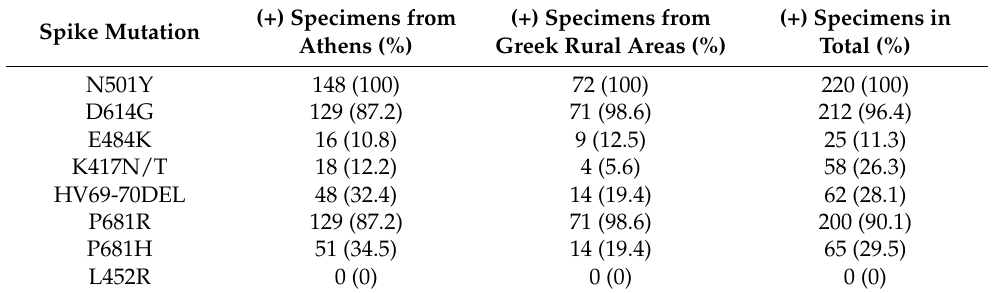
Table 1. Spike mutations investigated in our study and their proportion in the collected specimens. (+) Specimens from (+) Specimens from (+) Specimens in Spike Mutation Athens (%) Greek Rural Areas (%) Total (%) N501Y 148 (100) 72 (100) 220 (100) D614G 129 (87.2) 71 (98.6) 212 (96.4) E484K 16 (10.8) 9 (12.5) 25 (11.3) K417N/T 18 (12.2) 4 (5.6) 58 (26.3) HV69-70DEL 48 (32.4) 14 (19.4) 62 (28.1) P681R 129 (87.2) 71 (98.6) 200 (90.1) P681H 51 (34.5) 14 (19.4) 65 (29.5) L452R 0 (0) 0 (0) 0